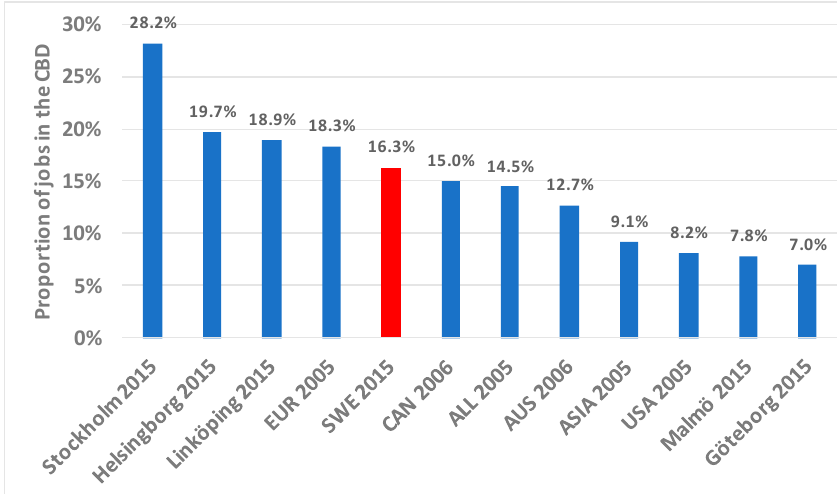
Figure 2. Urban density in five Swedish cities (2015) compared to a sample of global cities (2005–2006).